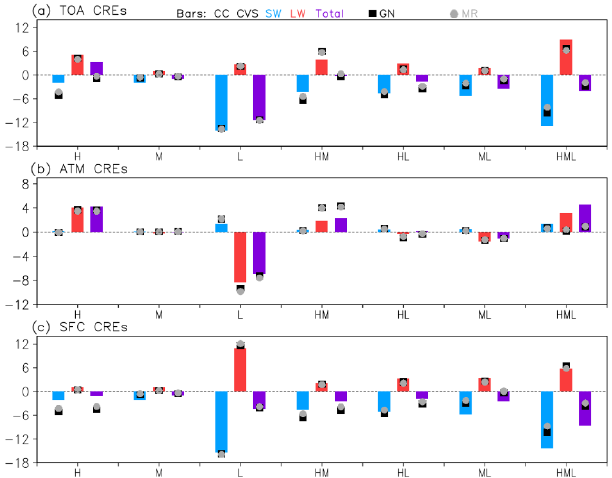
Figure 4. Comparison between observations and the model (GN and MR) of global overcast CREs (Wm − 2 ) : top of the atmosphere (TOA) (a) , surface (SFC) (c) , and atmospheric column (ATM) (b) derived as the difference between the TOA and SFC CREs. CREs are distinguished into shortwave (SW) and longwave (LW) compo- nents, and their sum, the “total” CREs for each CVS class, are also shown. Note that the y -axis range is the same for TOA and SFC CRE, but it is substantially more compressed for ATM CRE.